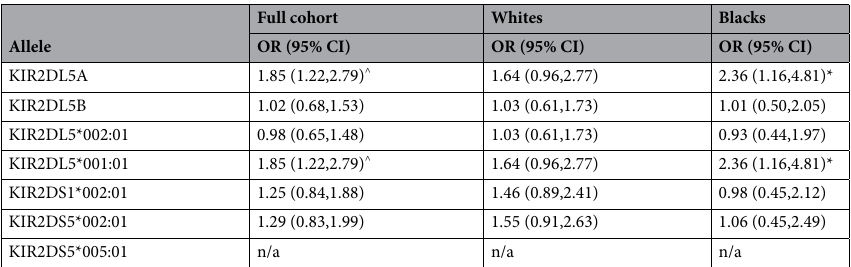
Table 3. Odds ratios and 95% CI for the association of atopic dermatitis for KIR alleles of interest evaluated by the presence or absence of the allele. Only alleles with variant frequency ≥ 0.05. n/a—unstable estimate due to insufficient sample size. *p < 0.05, ^ p <